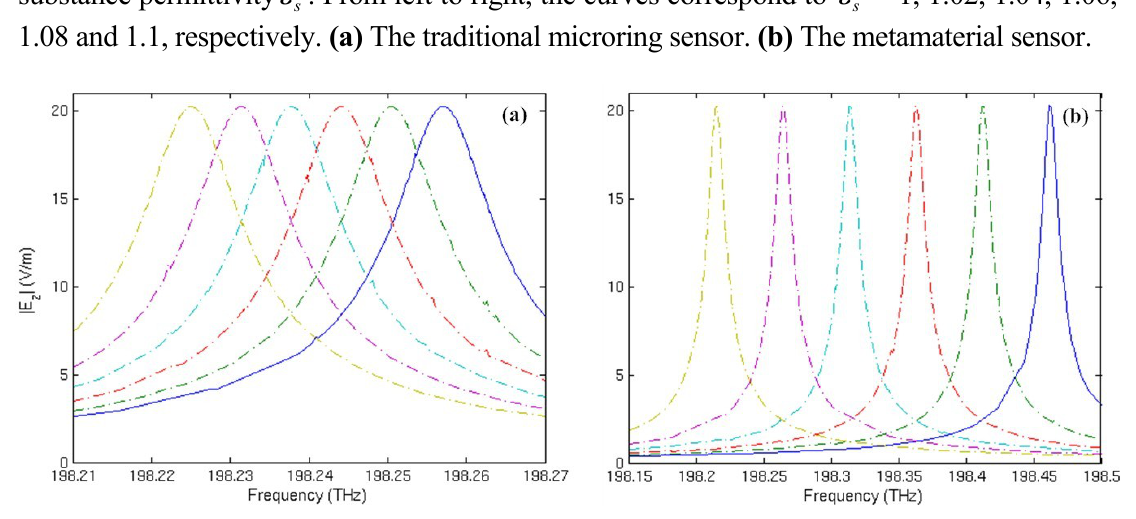
ε = 1, 1.02, 1.04, 1.06, s